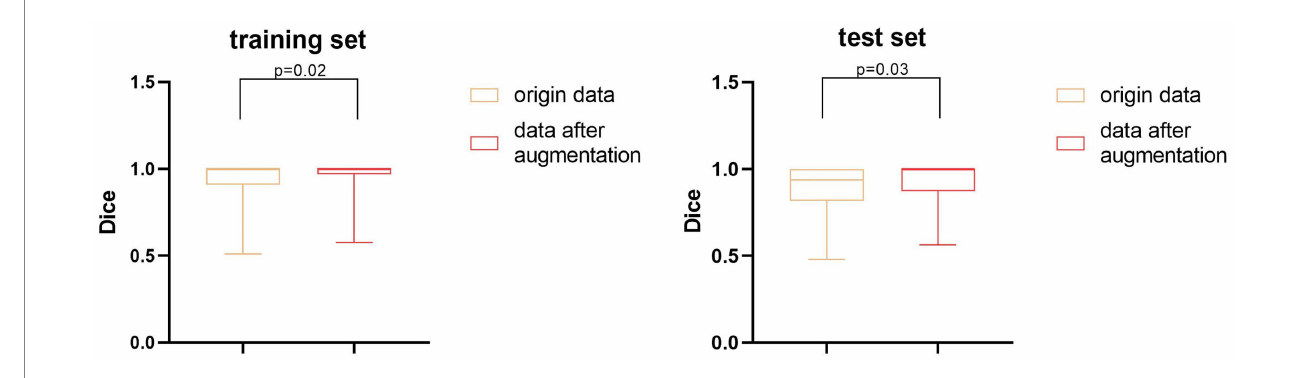
FIGURE 3 The distribution of Dice coefficients of segmentation results.